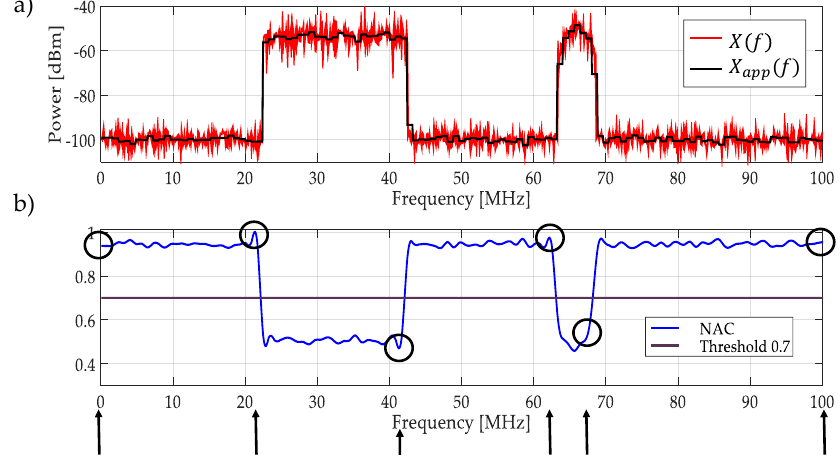
Figure 6. ( a ) The original and the approximated signal at decomposition level of 3. ( b ) The normalized and interpolated approximation coefficients (NAC) which mark the frequency edges and the same time that gives the dynamic windows and a threshold of